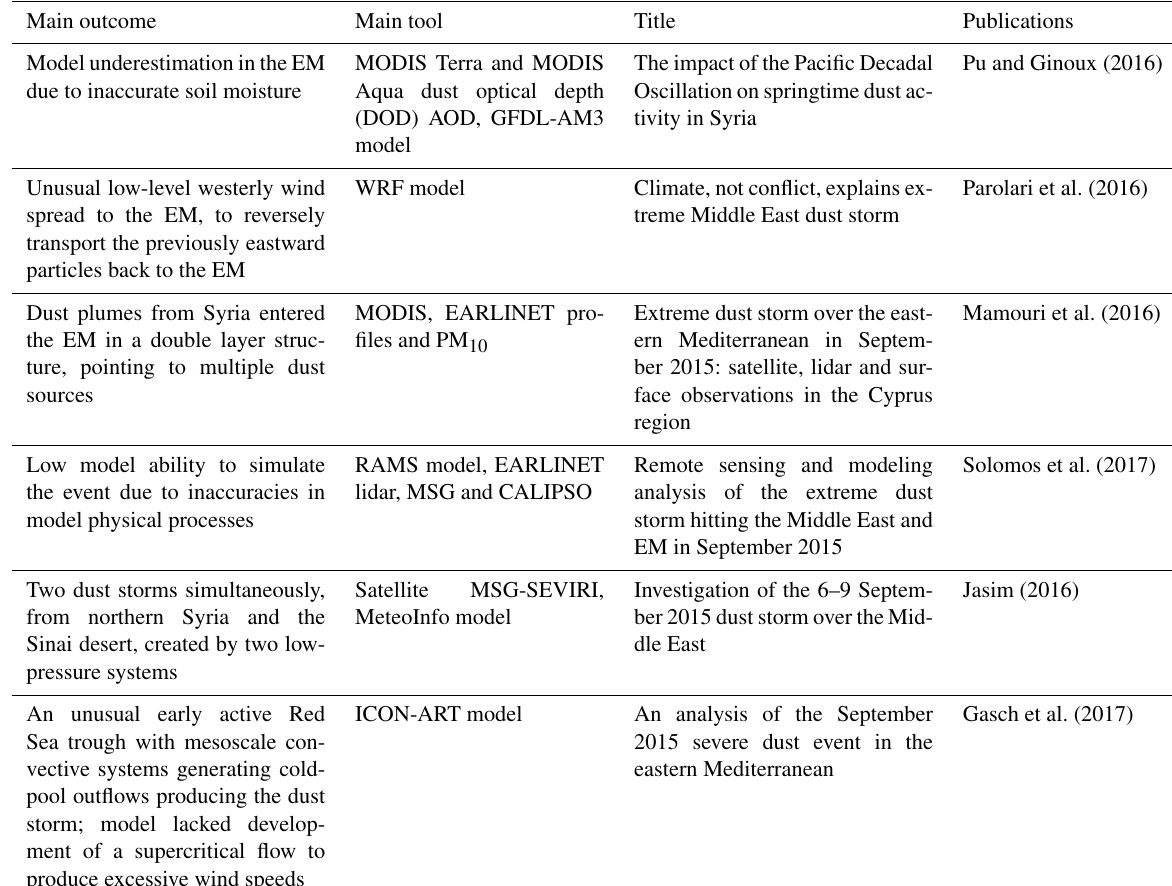
Table 1. The publications on the September 2015 dust event. Main